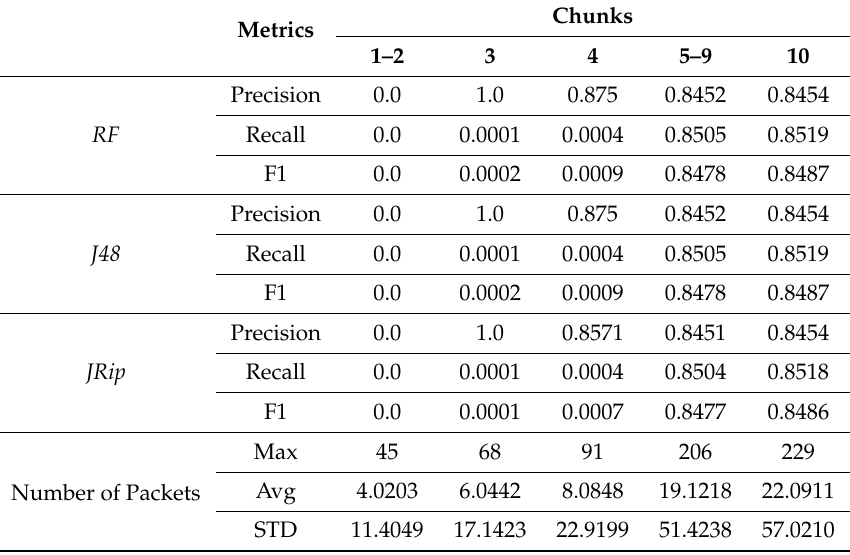
Table 1. Performance for state-of-the-art machine learning